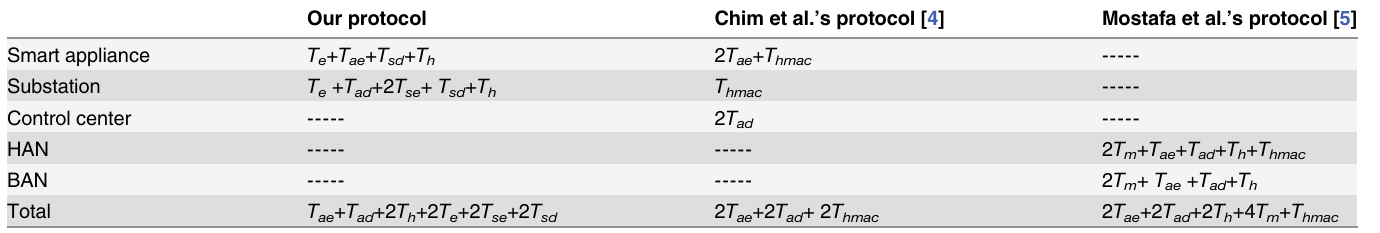
Table 2. Computational costs comparison between our protocol and